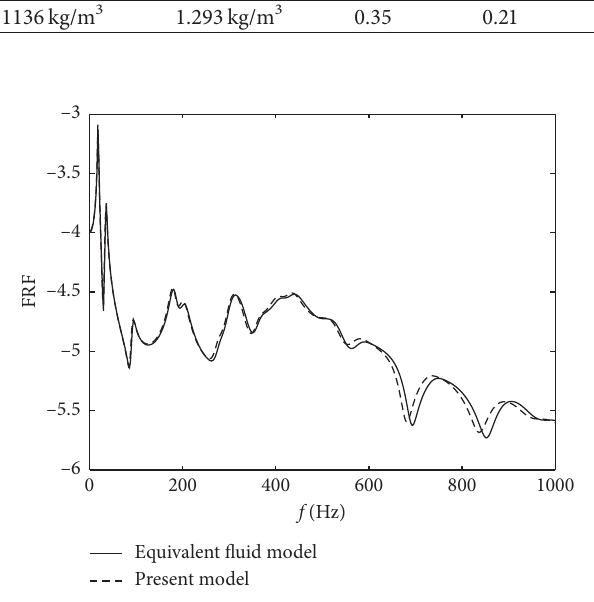
Figure 4: Comparison between the effective density fluid method and the present method.